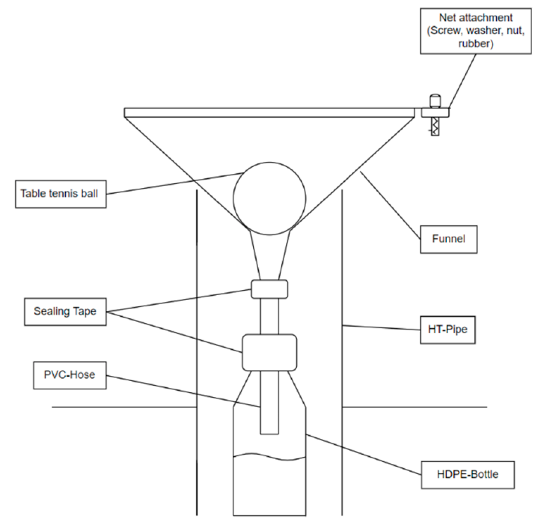
Figure A1. A schematic diagram of a precipitation collector.